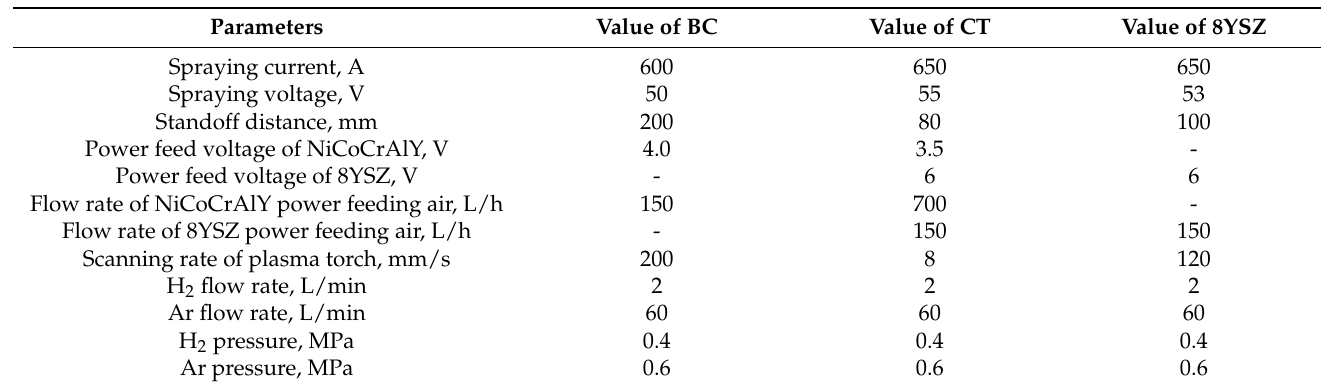
Table 3. The specific spraying process